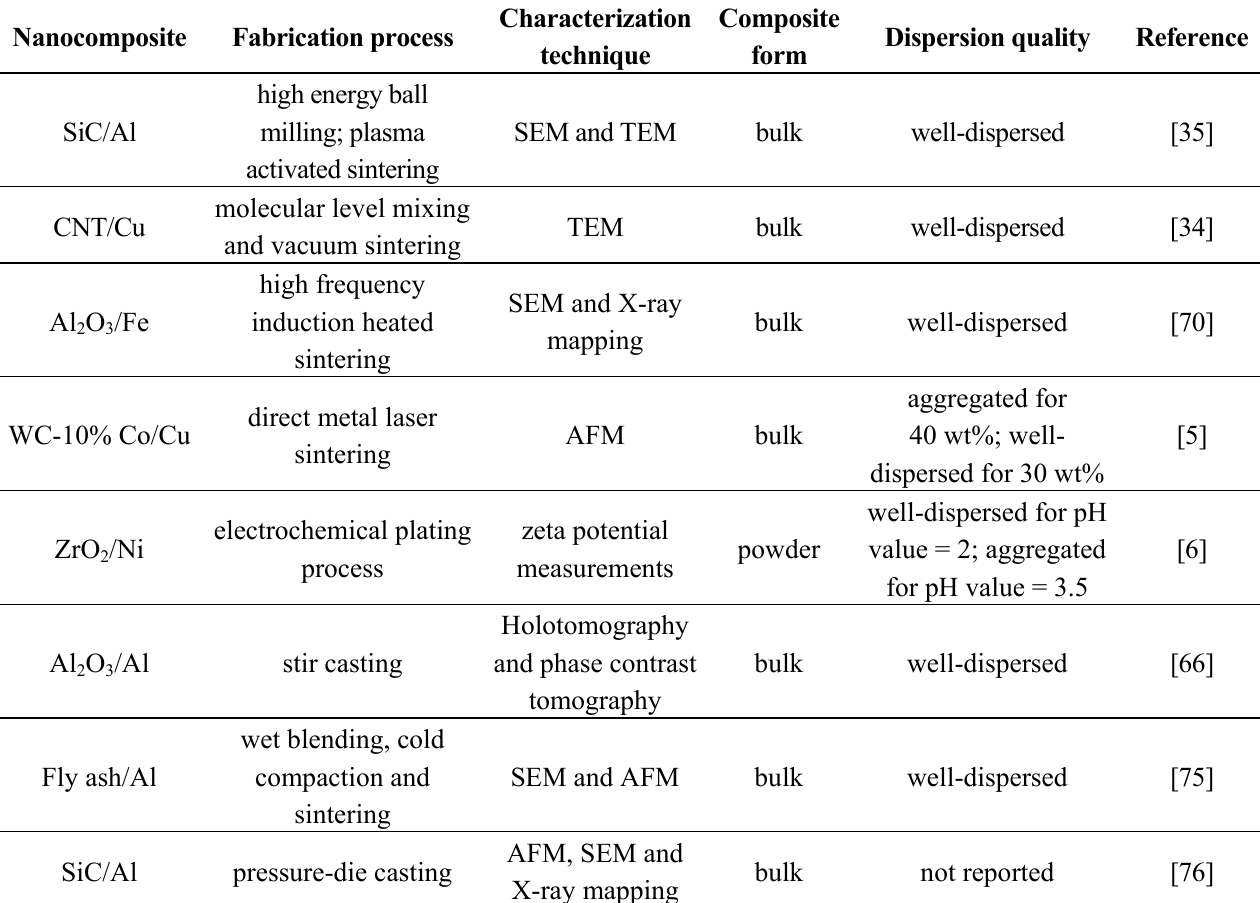
Table 2. Extent of reinforcement dispersion in selected metal matrix nanocomposites